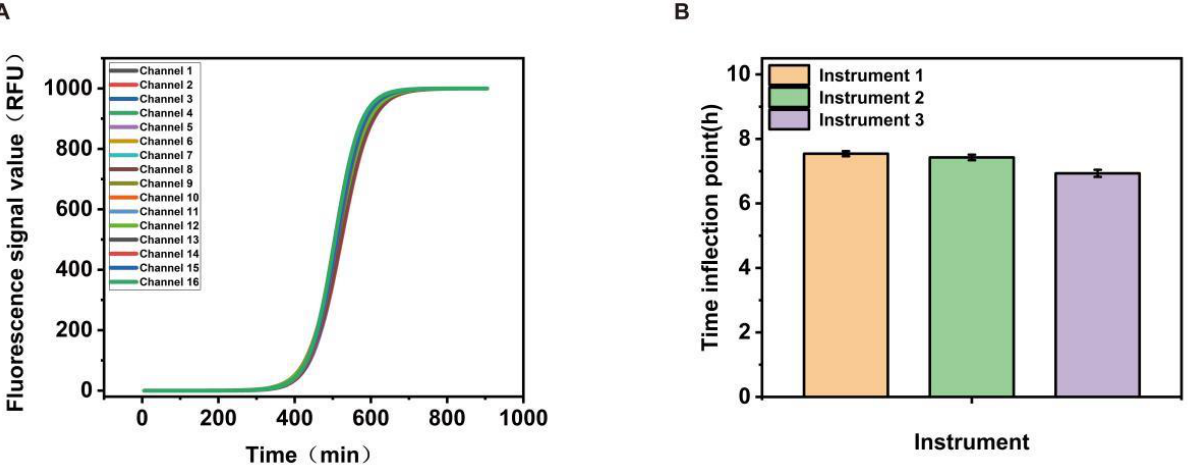
Figure 3. ( A ) shows the consistency among the various channels of the instrument; ( B ) shows the differences with different instruments.